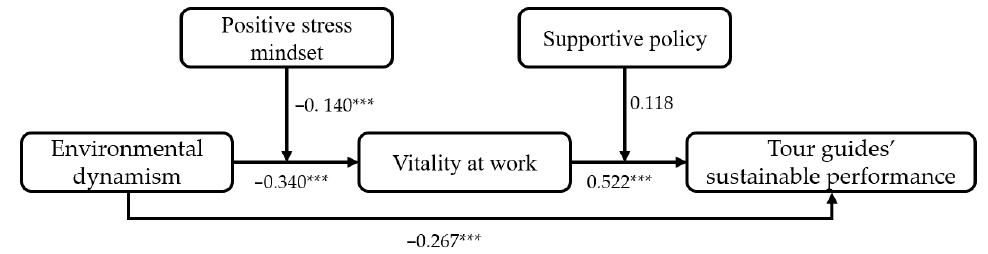
Figure 2. Path coefficients of the main variables. Note: *** p < 0.001. To make the graphics concise, Figure 2 does not present the path coefficients of control variables that were actually included in the testing model.